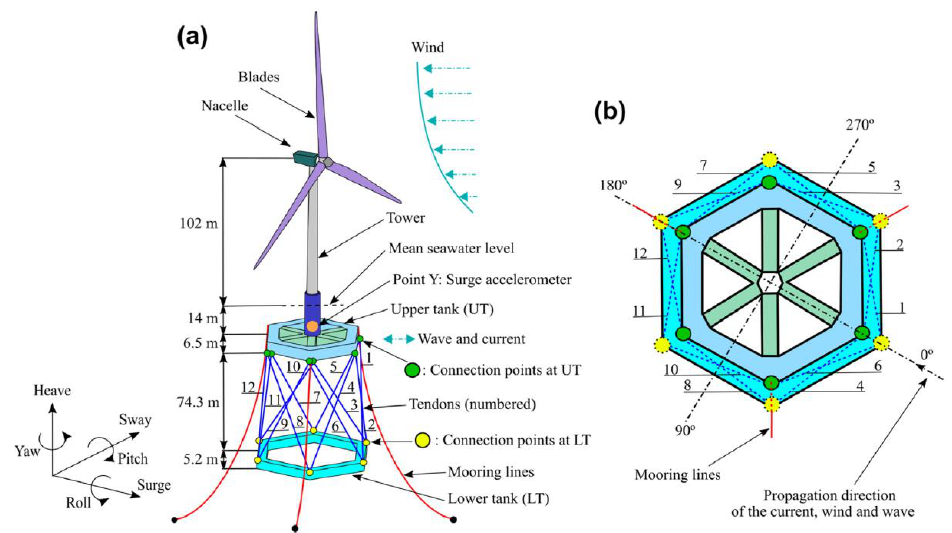
Figure 1. The 10 MW multibody FOWT. ( a ) Fully assembled floating wind turbine showing all components and position of load measurement. ( b ) The plan view of the multibody platform.